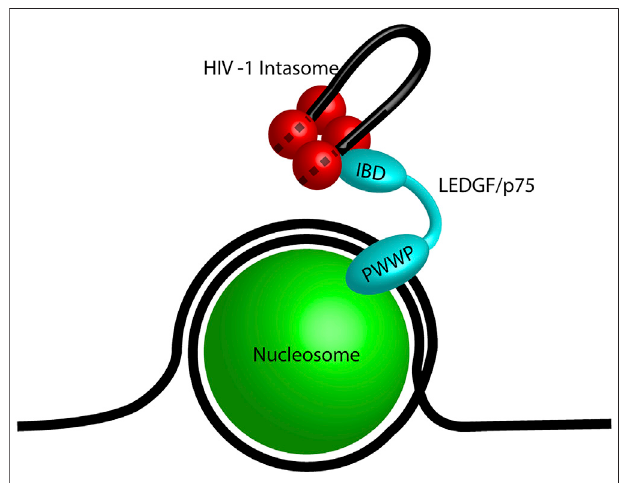
FIGURE 5 | Model of LEDGF/p75 tethering an HIV-1 intasome. A mononucleosome (green) wrapped in DNA (black line) representing a nucleosome. The PWWP domain of LEDGF/p75 (cyan) binds the post translational modi fi cation H3K36me3. The integrase binding domain (IBD) of LEDGF/p75 is bound to the HIV-1 intasome (red) which is shown as a tetramer for simplicity. The viral DNA genome is shown in black and the dashed lines represent the viral DNA within the